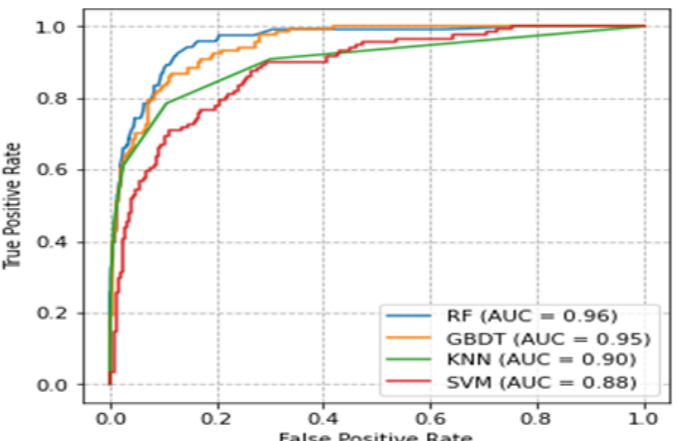
Figure 4. A comparison between ROC curves of the four classifiers: RF, GBDT, KNN and SVM. The AUC of each classifier is displayed.